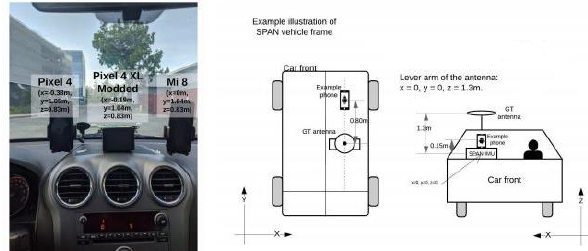
Figure 2. © Placement and position of the receivers relative to each other (Kaggel, 2020) (The left picture in figure2 shows the car's dashboard and smartphone's place, and the right one presents a geodetic antenna placed on the car's roof and the lever arm between this antenna and smartphones.)